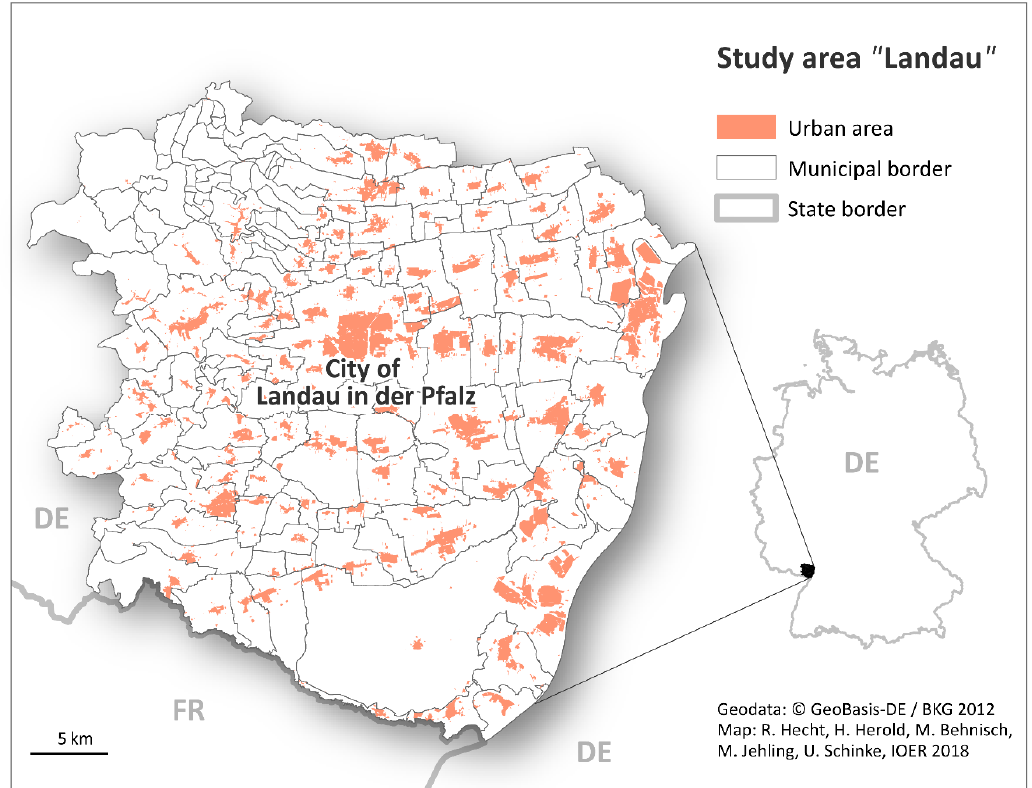
Figure 5. Administrative structure and urban area of the study area “Landau” and location in Germany.